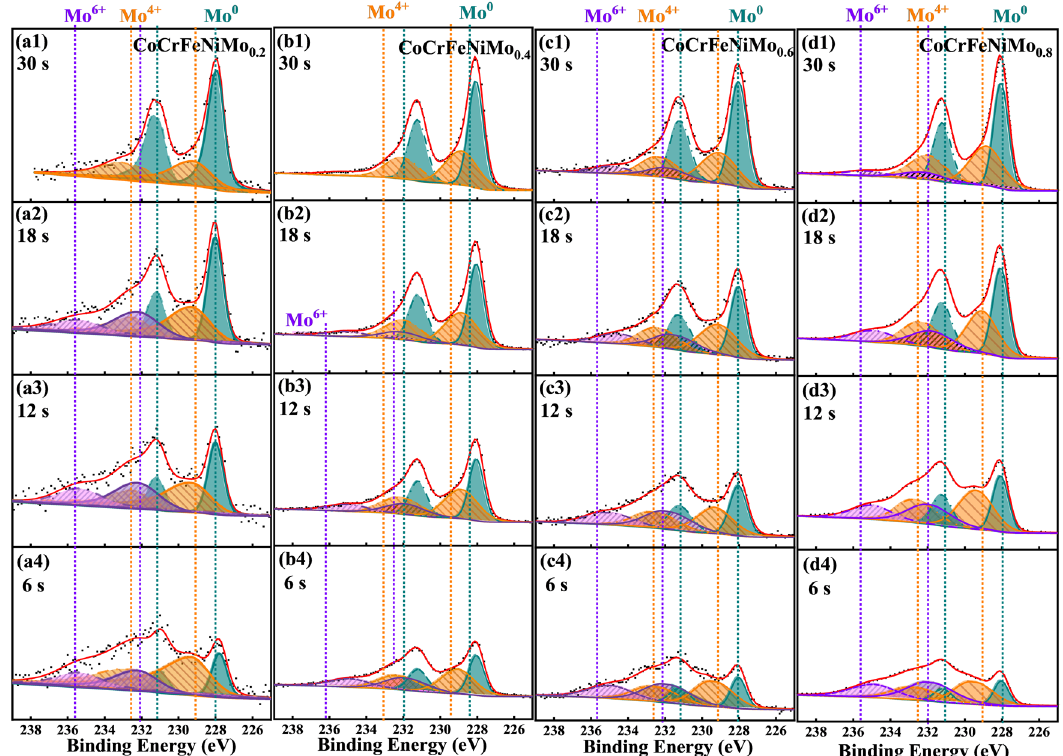
Fig. 12 The detailed XPS spectra of Mo 3d of the passive fi lms. a Mo 0.2 , b Mo 0.4 , c Mo 0.6 , and d Mo 0.8 HEAs.